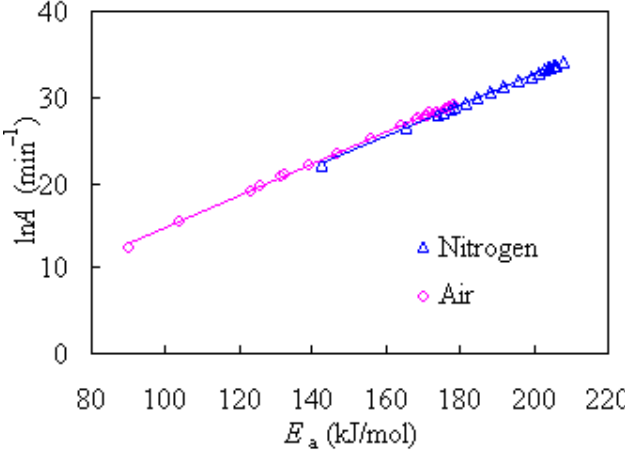
Figure 8. Compensation effect observed between ln A and E a for nylon-6 tennis string waste. With fully obtained kinetic parameters, the theoretical predictions to thermal degrada- tion processes can be made, and Figure 9 presents the matching results against experimental values using the CR method. It can be observed that the F1 model coupled with the E a and ln A parameters over the entire range of 0.05–0.95 performed satisfactorily to recast the temperature-dependent mass-conversion curves for nylon-6 waste samples since all the experimental data points selected are mostly condensed on their respective α - T curves.